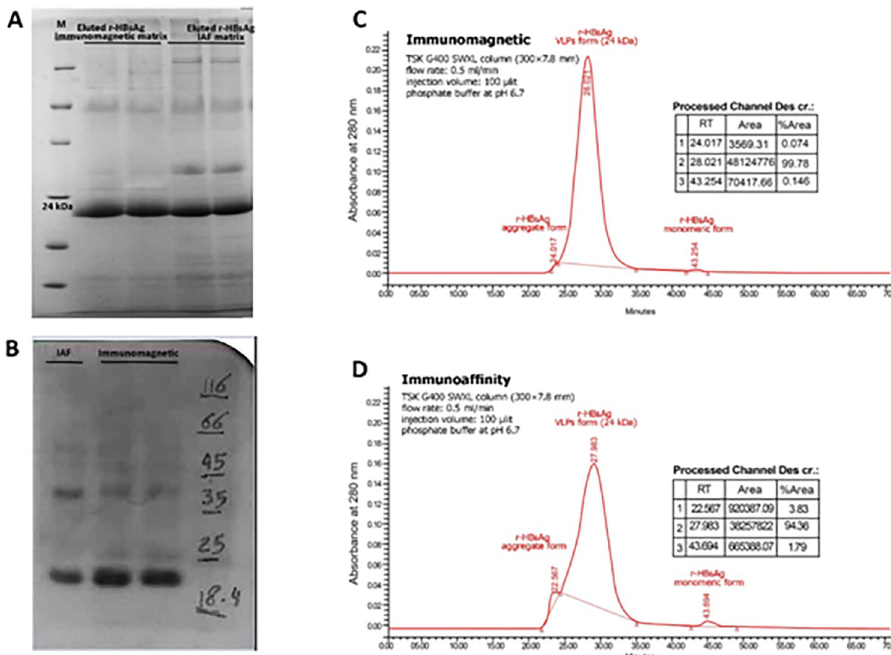
Fig 5. Characterization of eluted rHBsAg by immunomagnetic separation (IMS) or immunoaffinity chromatography (IAC). (A) SDS-PAGE analysis show the 24 KD band corresponding to rHBsAg purified by immunomagnetic separation method. (B) Western blot analysis show the 24 KD band corresponding to rHBsAg purified by immunomagnetic separation method. (C) and (D) Size Exclusion High-performance liquid chromatography (SEC-HPLC) analysis of eluted r-HBsAg to determine and quantify the level of VLP, monomeric and aggregated forms of eluted r-HBsAg by IMS and IAC methods, respectively.